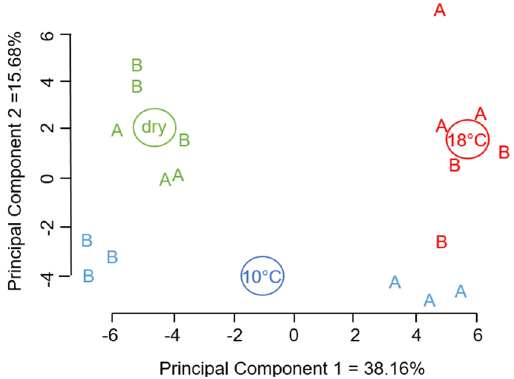
Figure 4. Principal component analysis (PCA) of membrane composition of embryos of hybrids (A and B). Score plot of lipid species content of dry seeds (green) and seeds imbibed for 24 h at 10 °C (blue) or 18 °C (red). Each letter represents a replicate of hybrid (A or B). Principal components 1 and 2 (PC1 and PC2) explain 38.16% and 15.68% of the variance in the data set. Loadings can be found in Supplemental Table